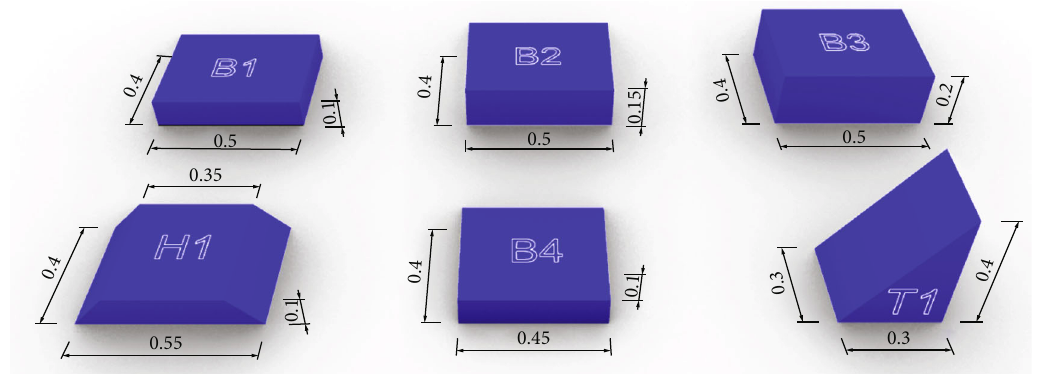
Figure 2: Schematic diagram of regular rigid blocks representing the landslide body (dimensions: